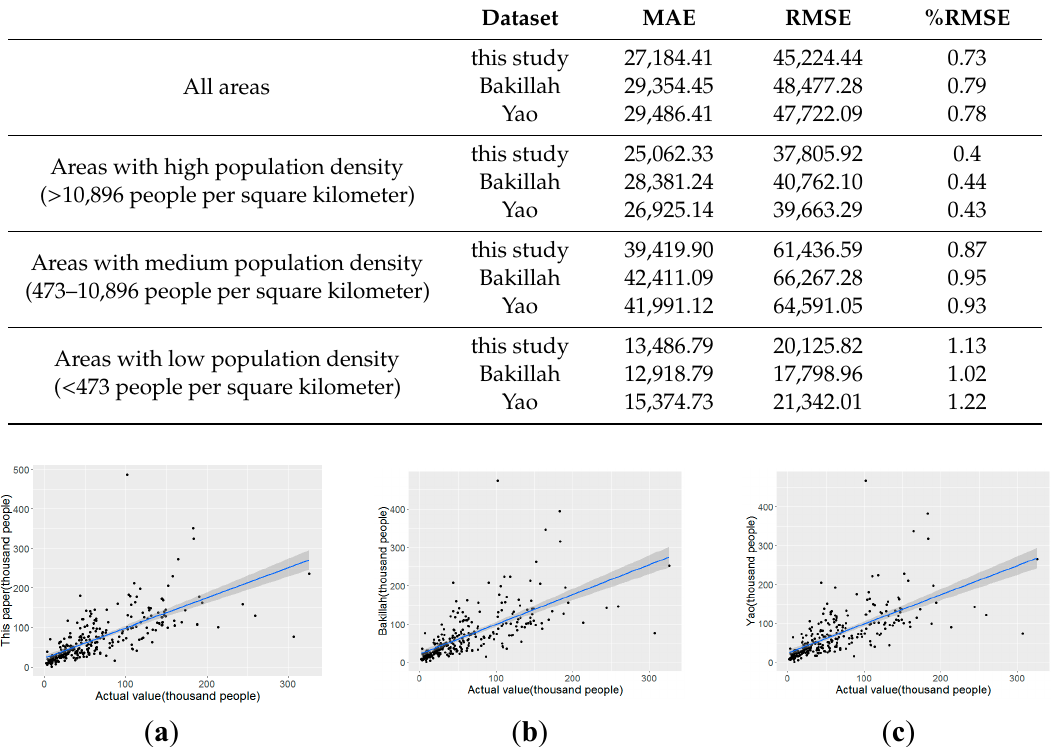
Table 5. Accuracy assessment of the dasymetric model driven by PSP and HDI POIs selected by others.